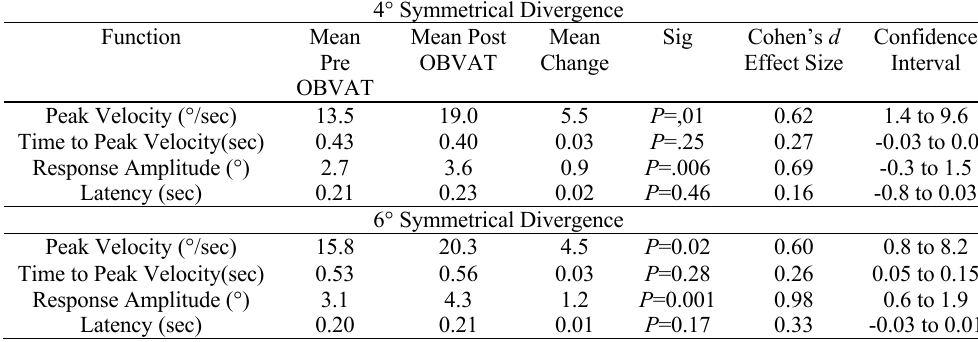
Table 3: Comparison of Objective Measures of Divergence Pre- and Post-OBVAT